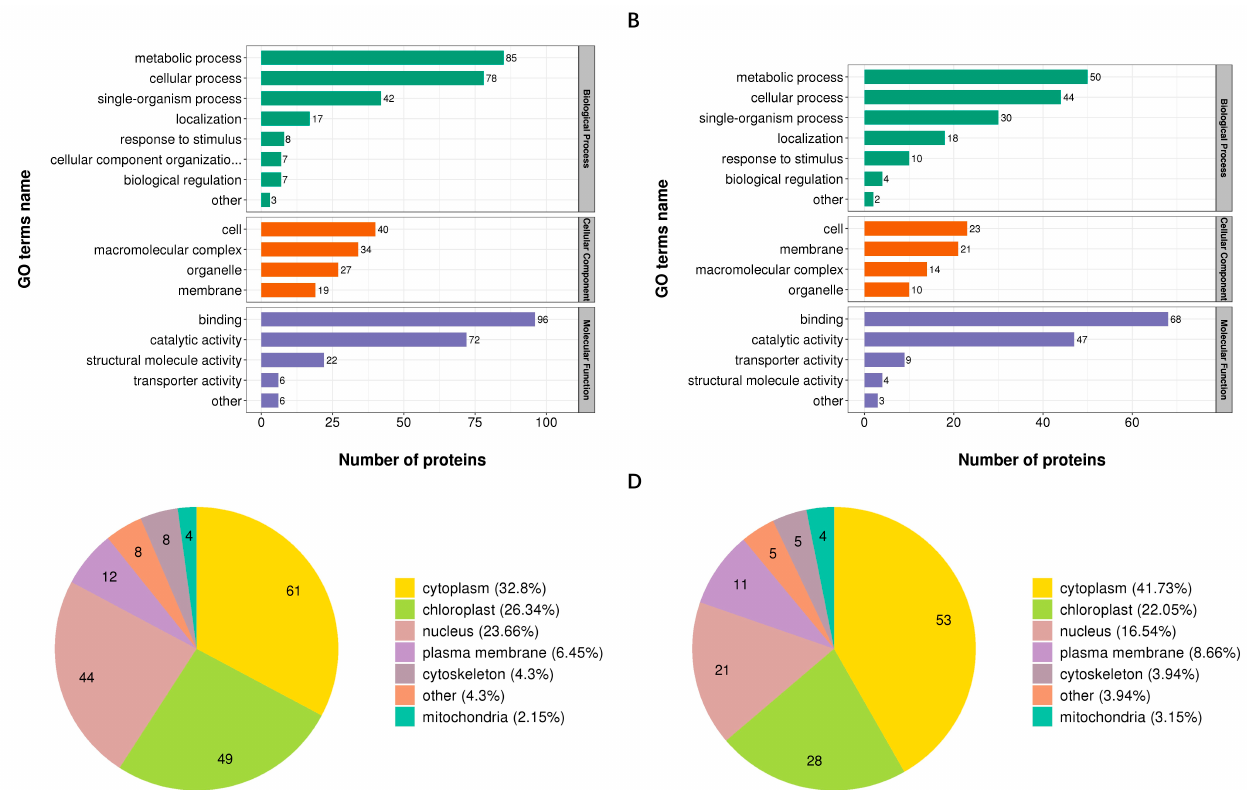
Figure 3. Classification of the identified proteins with DUSs. ( A , B ) GO annotation of proteins with up-regulated Kub sites ( A ) and down-regulated Kub sites ( B ) in “biological process category”, “cellular component category”, and “molecular function category”. ( C , D ) Subcellular localization of proteins with up-regulated Kub sites ( C ) and down-regulated Kub sites ( D ). Numbers in the sector diagrams represent the number of proteins that possess corresponding subcellular localization.